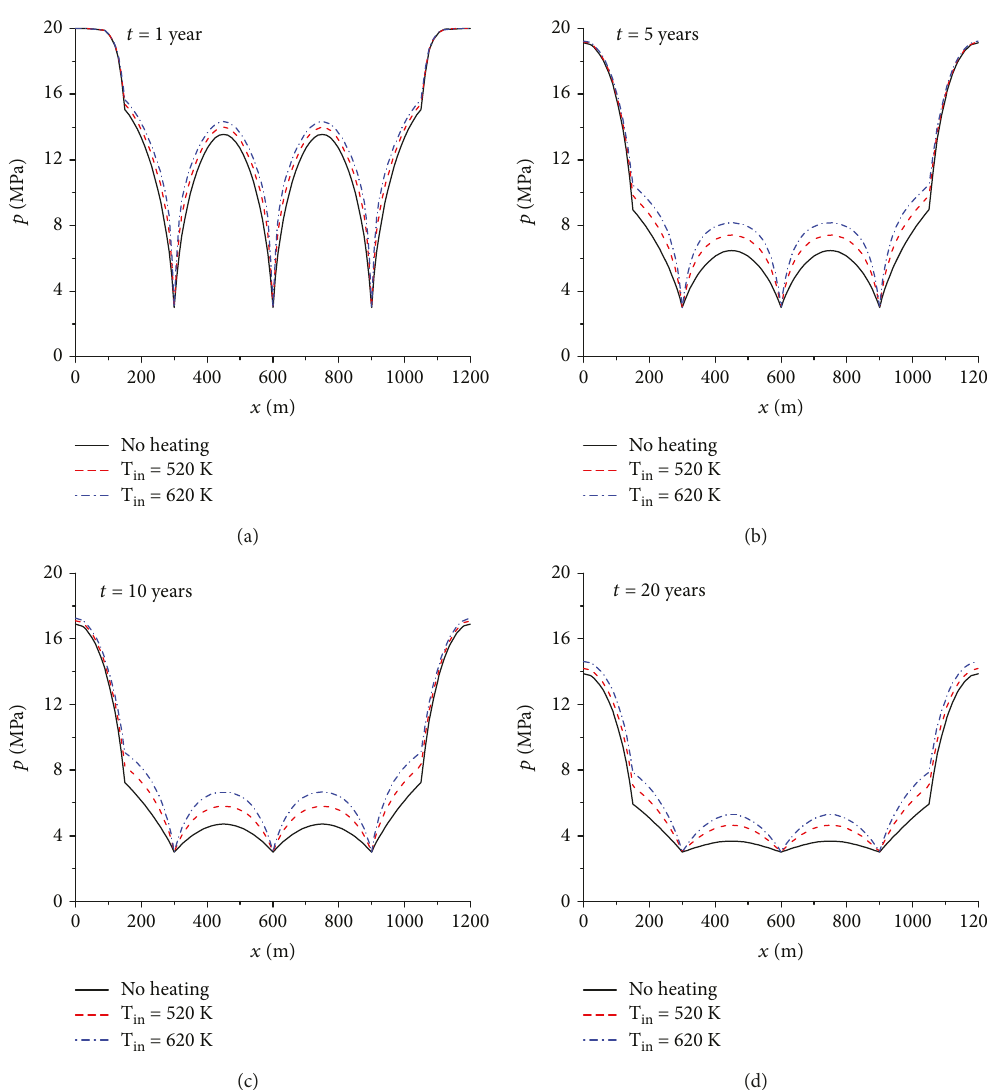
Figure 10: E ff ect of thermal stimulation temperature on formation pressure during the process of thermal stimulation (a) at 1 year, (b) at 5 years, (c) at 10 years, and (d) at 20